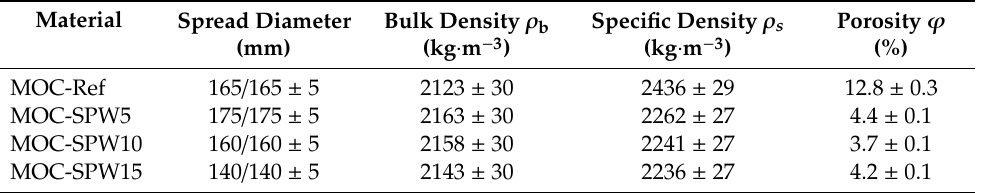
Table 4. Basic structural characteristics of MOC